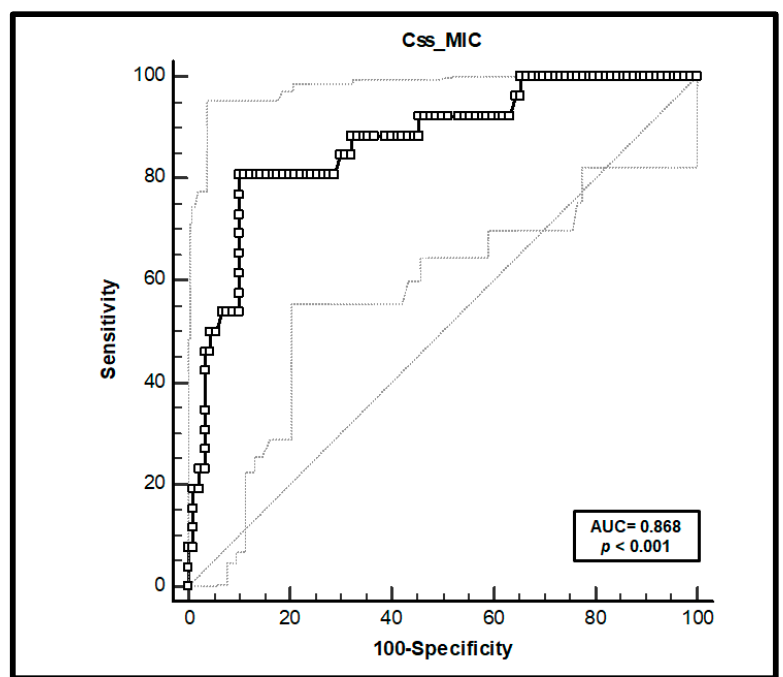
Figure 2. Receiver operating characteristic (ROC) curve analysis. An optimal cut-off of C ss /MIC ≤ 5 was found, resulting in a sensitivity of 80.8% and a specificity of 90.0%. The optimal cut-off point was computed using the Youden Index method. AUC: area under the curve; C ss : steady-state concentrations.